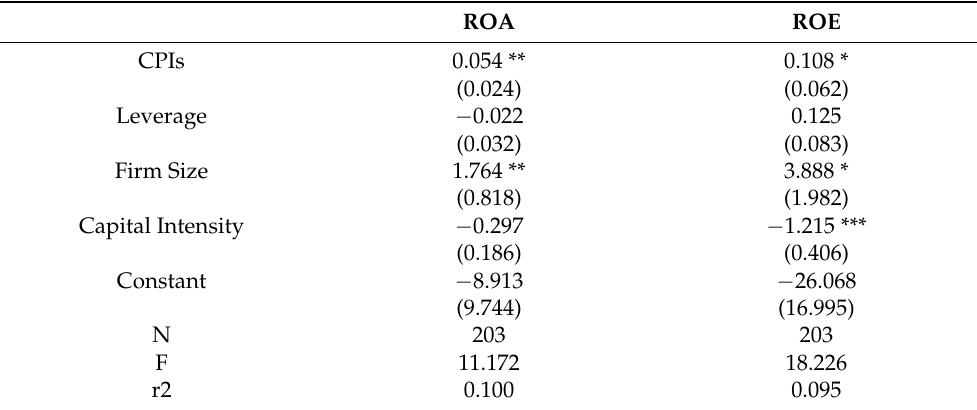
Table 9. Regression